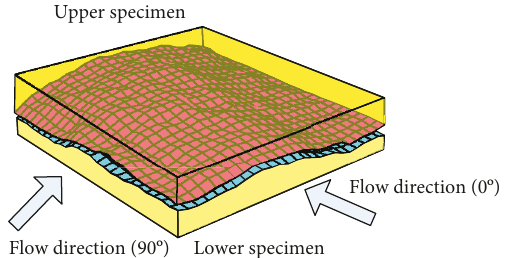
Figure 3: Di ff erent directions of fl ow (0 ° and 90 ° ) in a rock fracture.